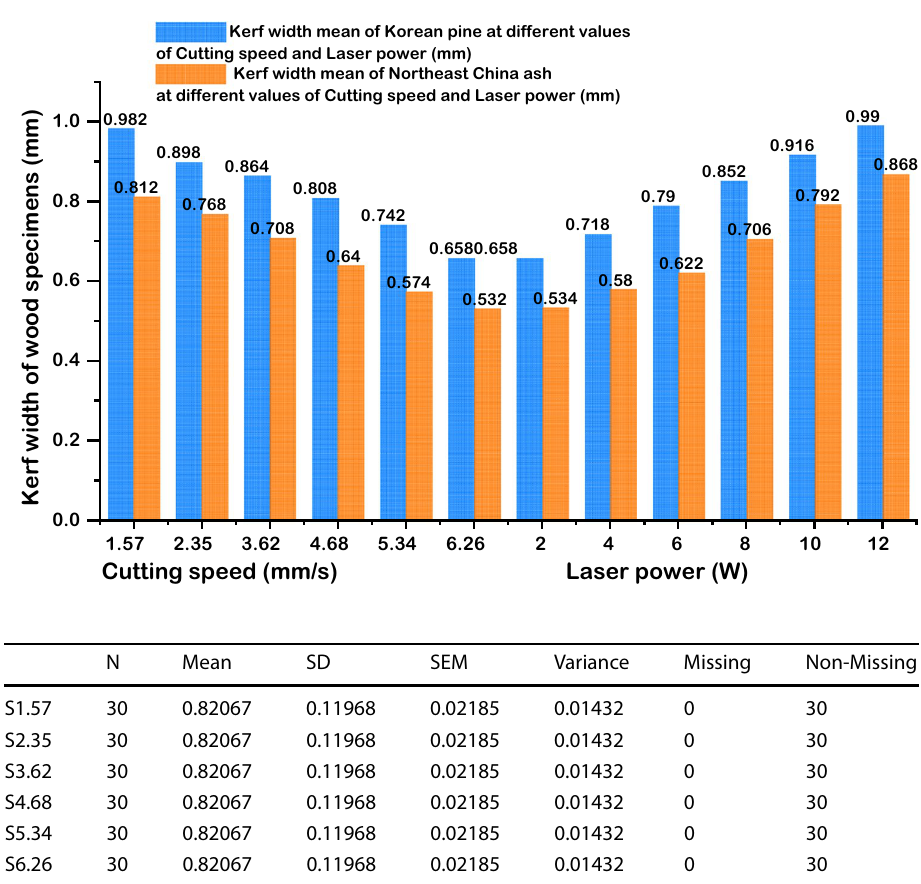
Table 22 Cutting